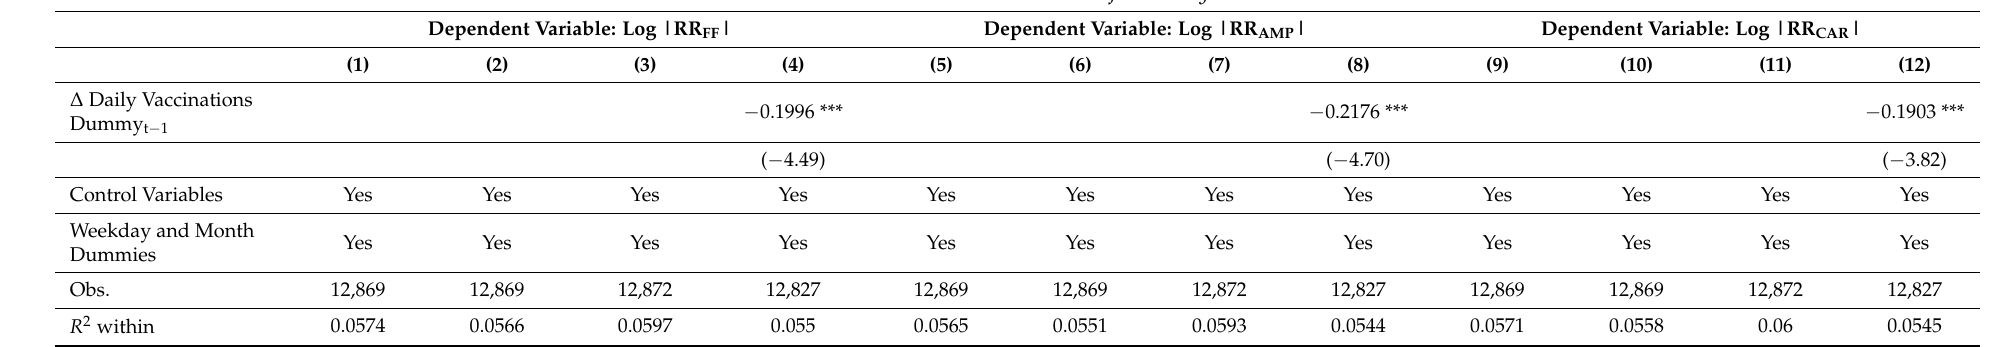
Panel B: Alternative Measures of Volatility